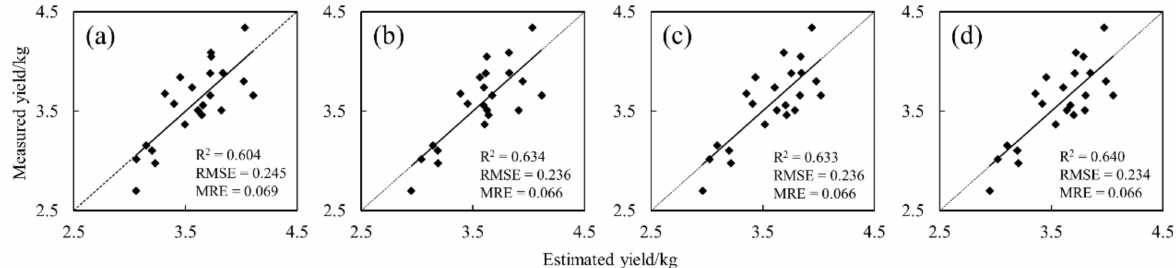
Figure 11. Accuracy-assessment results of the VI × (T − G) and VI × (T/B) models at the heading stage: ( a ) NDRE × (T − G); ( b ) NDVI × (T − G); ( c ) SAVI × (T/B); ( d ) EVI2 ×